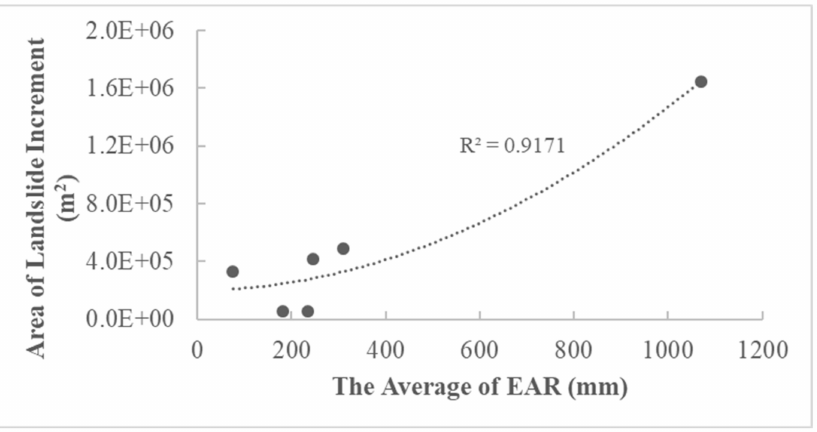
Figure 5. Regression line of the increase in the landslide area against the average EAR.